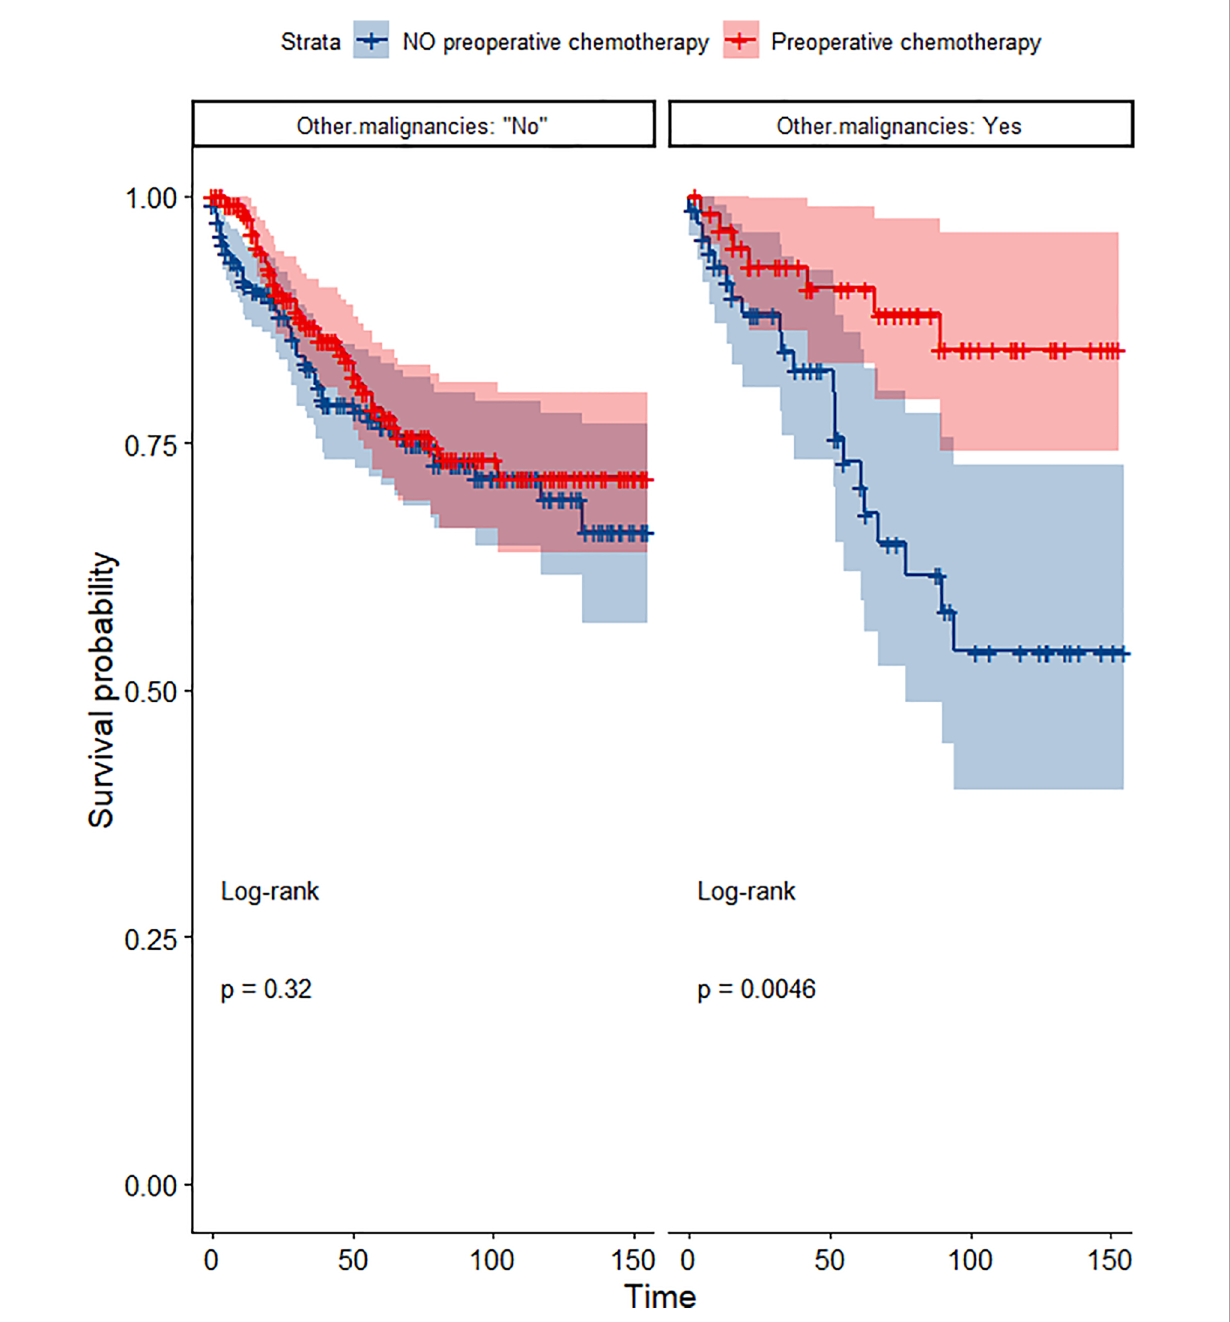
FIGURE 14 Survival curves of CSS in the POCT and no POCT groups in patients with or without other malignancies undergoing surgery for TETs after propensity